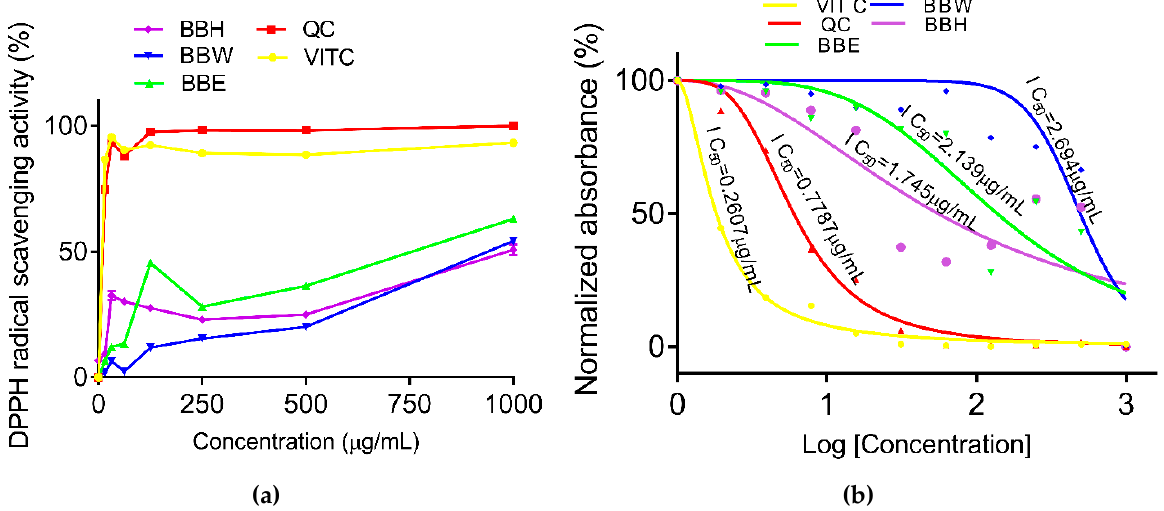
Figure 3. DPPH radical scavenging activity ( a ) and normalized absorbance of DPPH activity ( b ). DPPH: 1,1 diphenyl 2 picrylhydrazyl, BBE: bee bread ethanol extract (IC 50 : 2.139 µ g/mL), BBW: bee bread water extract (IC 50 : 2.694 µ g/mL), BBH: